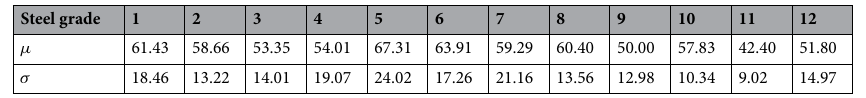
Table 2. Means and standard deviation of pretreatment time.